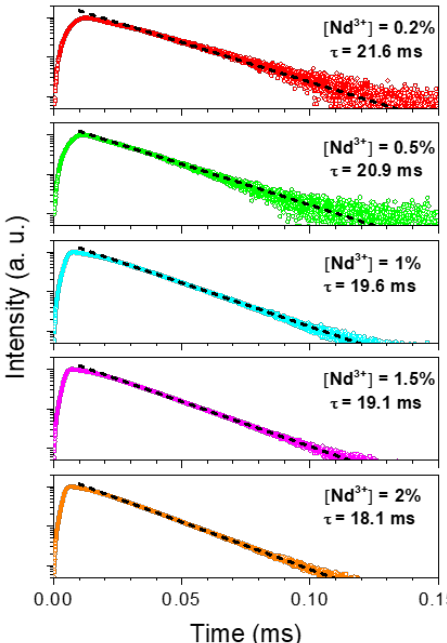
Figure 5. Temporal decays for the 4 F 3 / 2 → 4I13 / 2 transition (1344 nm) of the Nd:LuVO 4 nanoparticles with different Nd 3+ content in a semi-logarithmic plot. The decay time values correspond to the least squares fitting to Equation (1).